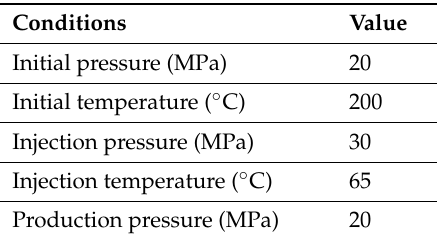
Table 3. Initial and Boundary